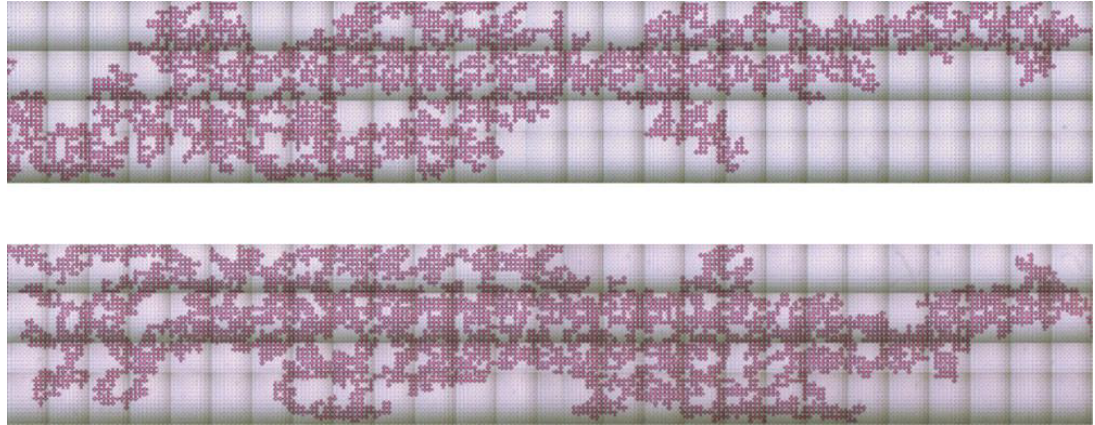
Figure 6. Water invasion pattern in two different hydrophilic porous media microfluidic devices manufactured from the same mask. Ca = 3.5 × 10 − 7 .